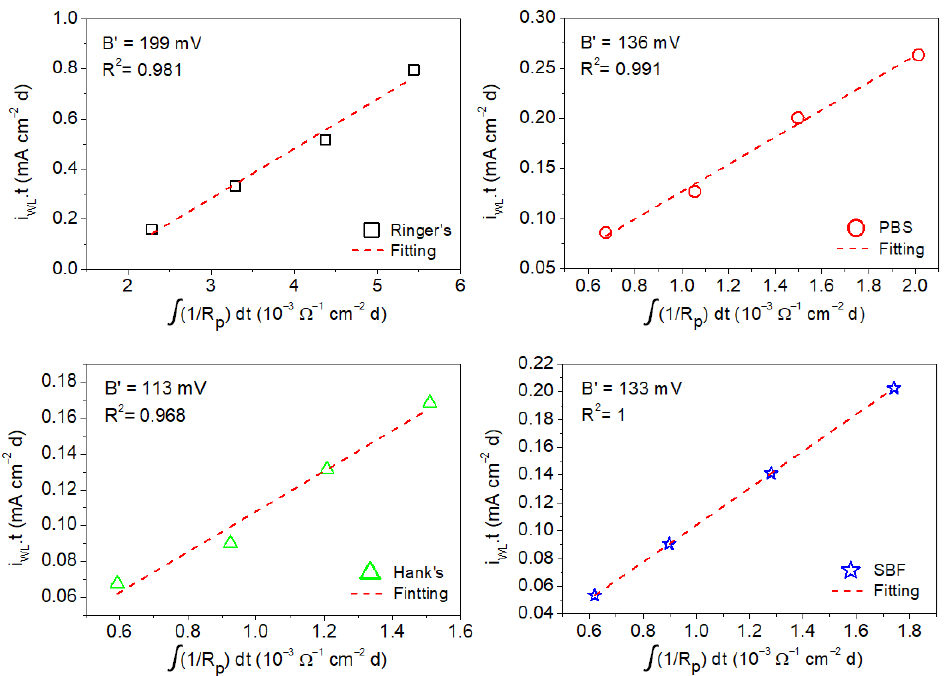
Figure 9. Charge values from weight loss measurements as a function of time-integrated reciprocal of the R p values determined by EIS for AZ31B alloy from measurement in Ringer’s, PBS, Hank’s, and SBF solutions.